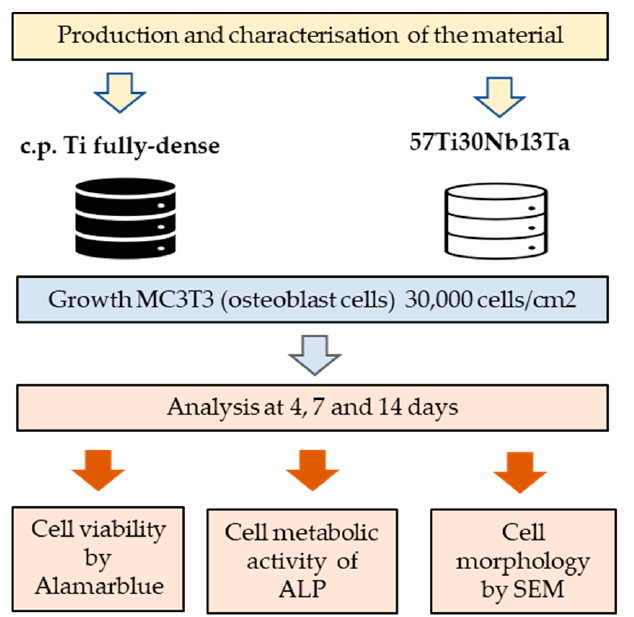
Figure 2. Diagram of in vitro experimental design. Osteoblast cell line (MC3T3E1) was used to analyze the biological response to fully dense Ti c.p. vs. TiNbTa samples.